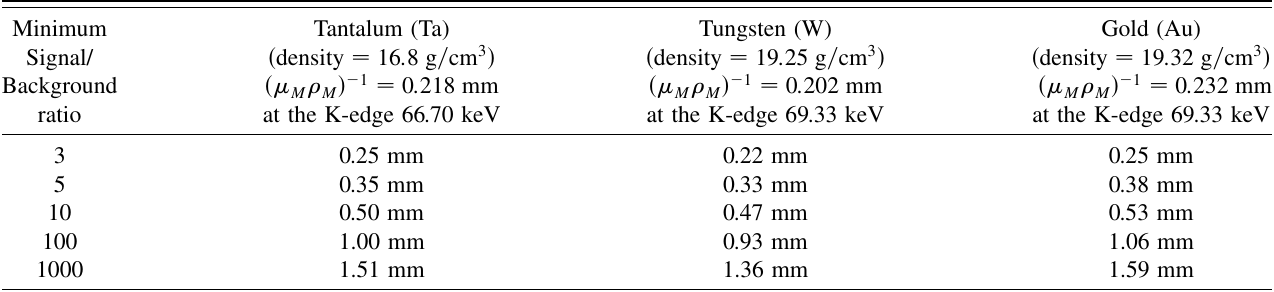
TABLE I. Required thickness of selected metal foils for minimum signal-to-background ratio (x-ray photon energy < 100 keV ). Minimum